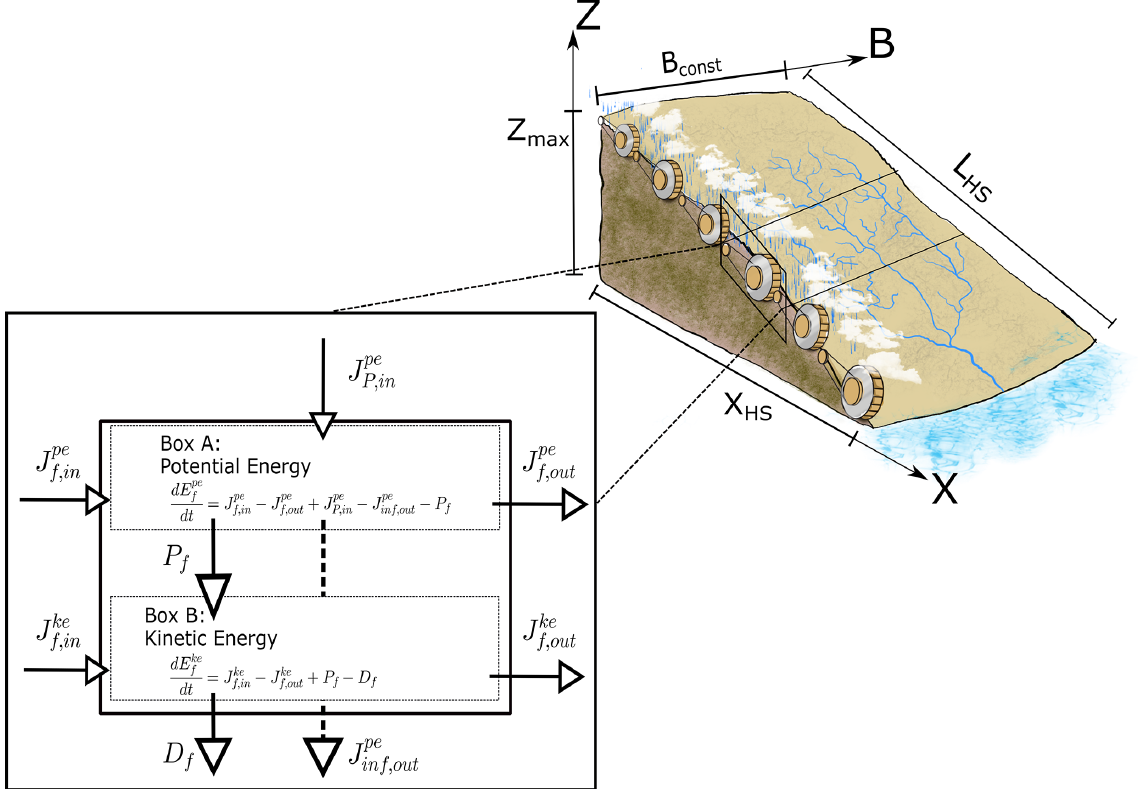
Figure 1. Hillslope open thermodynamic system with spatial division into a sub-OTS as a two-box open thermodynamic system. Each control volume (sub-OTS) is represented by a prony brake (compare Leopold and Langbein,